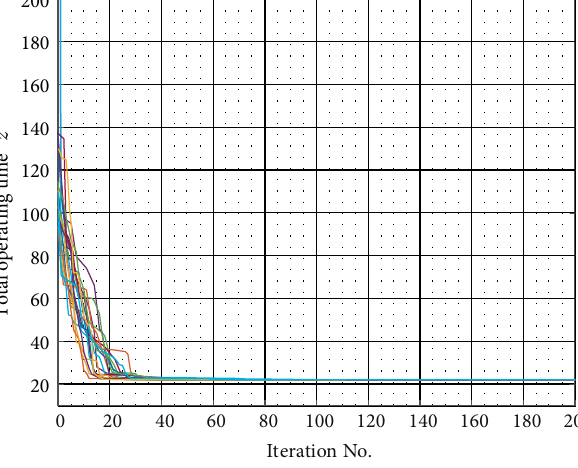
Figure 6: Convergence characteristics of JAYA for 20-time execution for Case